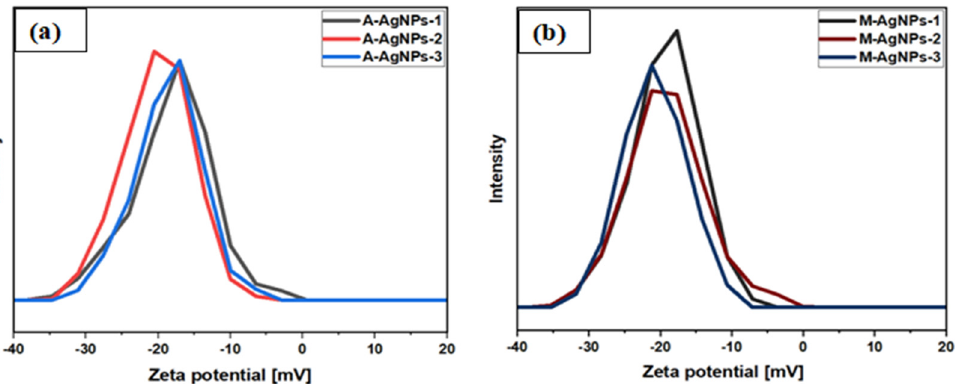
Figure 9. Zeta potential of stable ( a ) A-AgNPs and ( b ) M-AgNPs at ( − , “19.07 mV’’) and ( − , “17.2 mV’’).